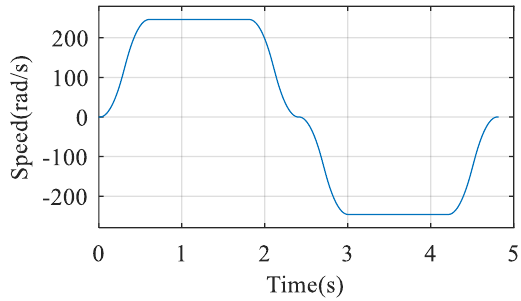
Figure 13. The speed control command of the motor.